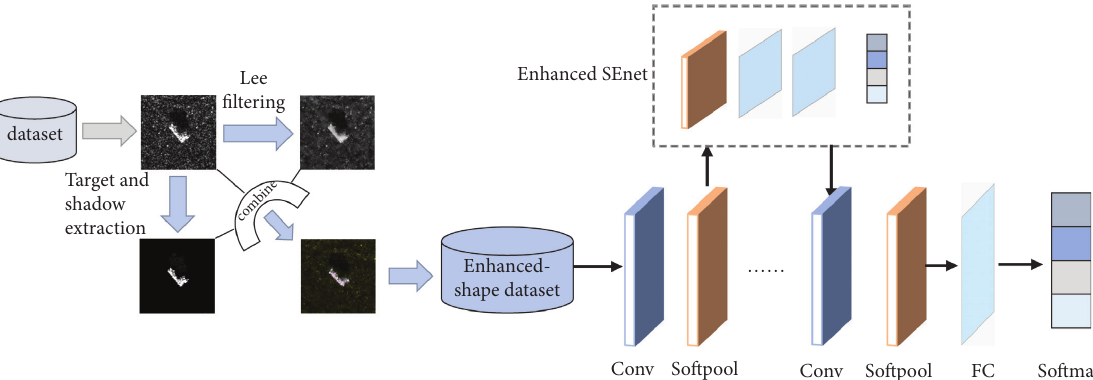
Figure 1: Structure of the enhances-shape